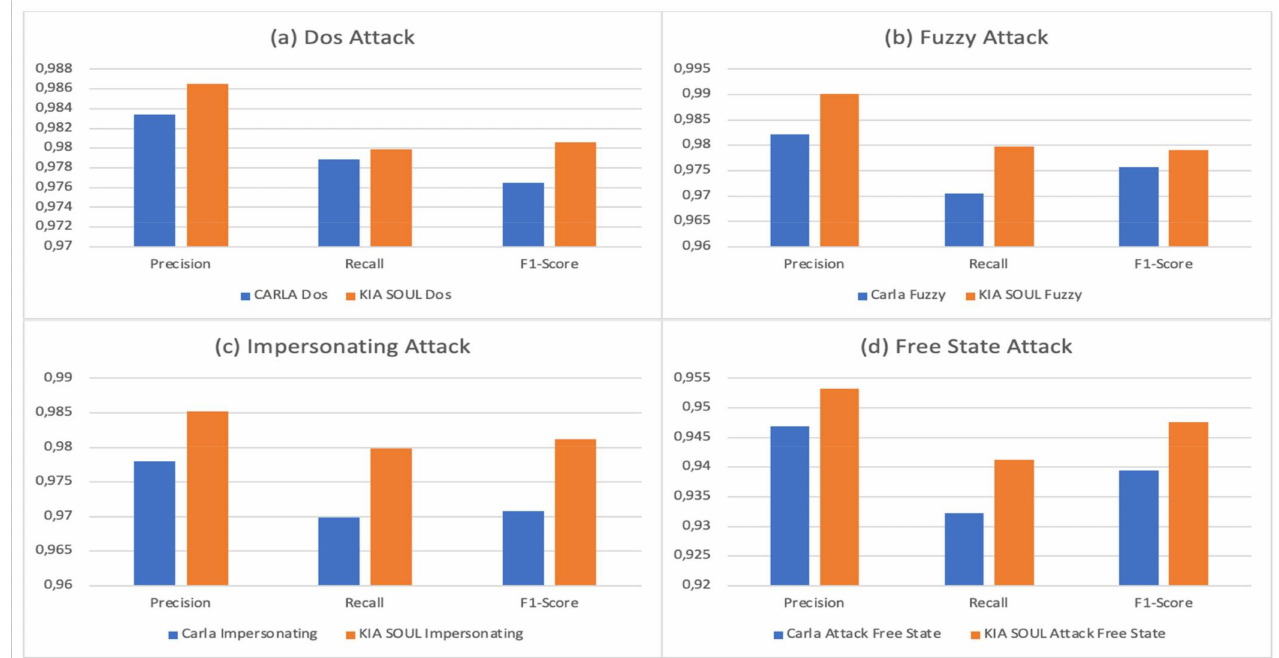
Figure 5. Precision, recall and F1-Score of experimental results: ( a ) Dos Attack, ( b ) Fuzzy Attack, ( c ) Impersonating Attack, ( d ) Free State